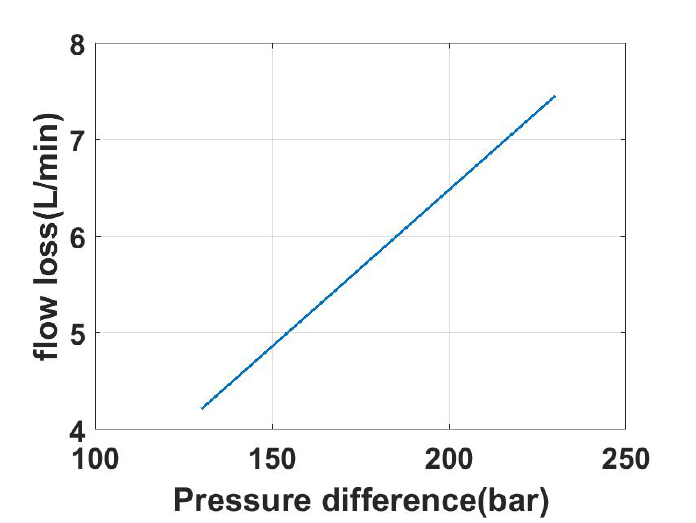
Figure 10. The flow loss of the